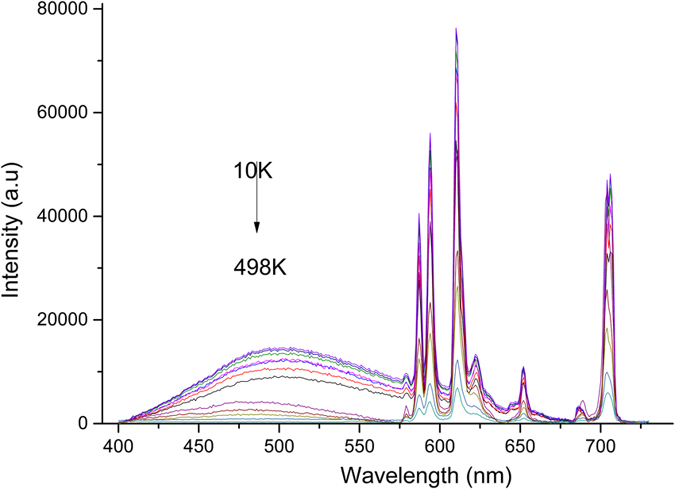
Emission spectra of Bi4Si3O12: 2 at% Eu3+ phosphors at different temperatures.